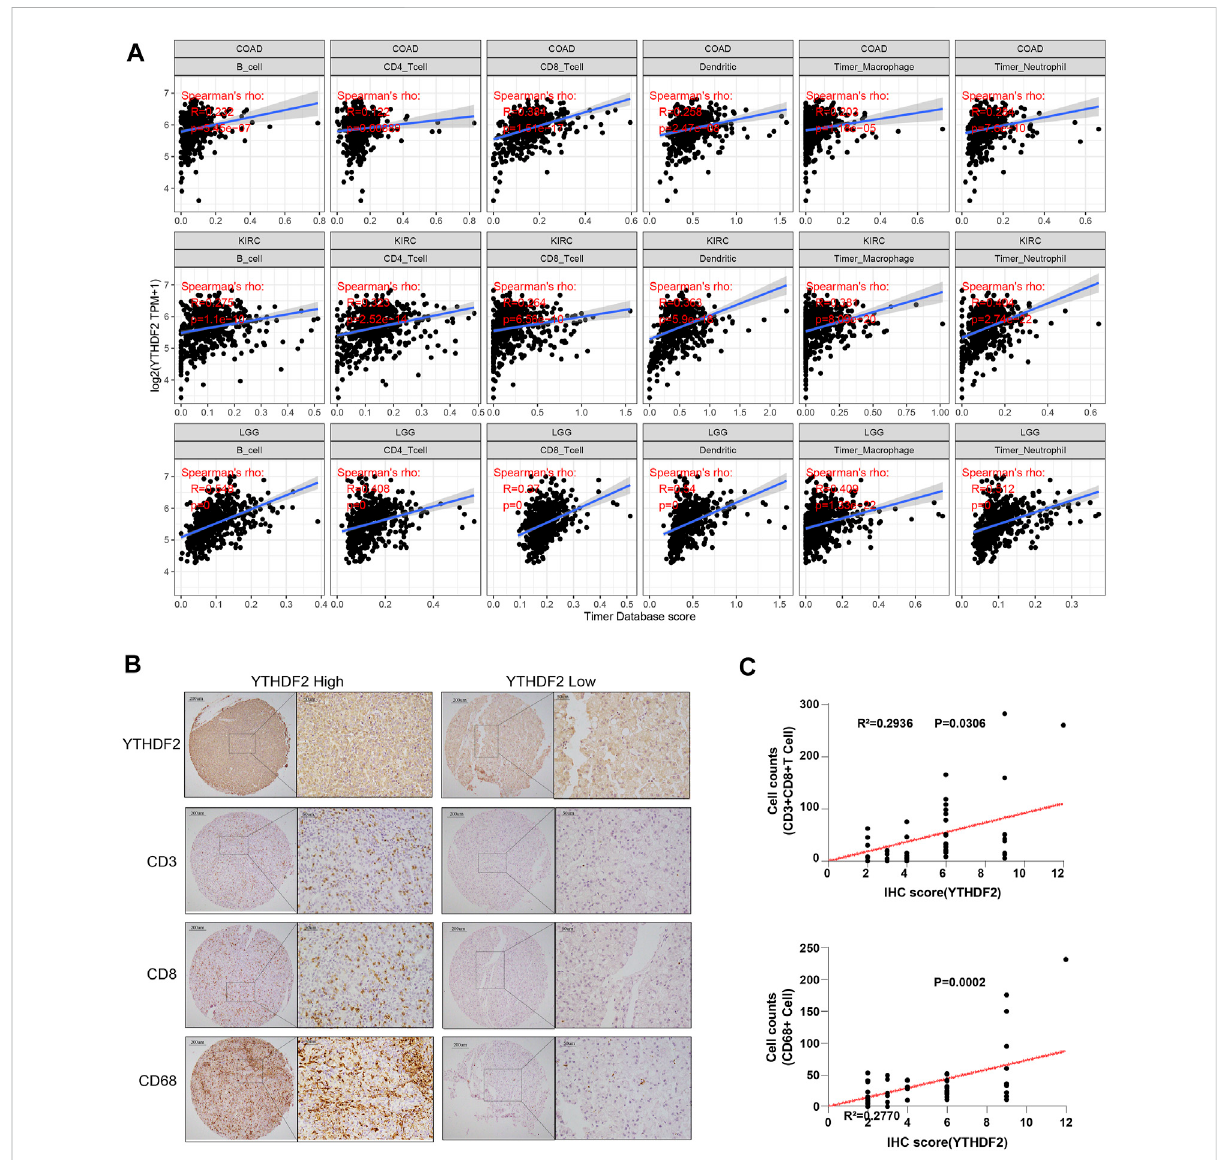
FIGURE 6 ThecorrelationbetweenYTHDF2expressionandimmunein fi ltrationindifferentcancertypes. (A) ThecorrelationbetweenYTHDF2expression and immune in fi ltration in the top three tumors. (B) Immunohistochemical images of hepatocellular carcinoma show intra-tissue characteristics of CD3 + CD8 + T cells/CD68 macrophages with high and low expressionof YTHDF2. (C) The correlation analysis of YTHDF2 expressionwith CD3 + CD8 + T cells and CD68 macrophage in fi ltration in hepatocellular carcinoma validation